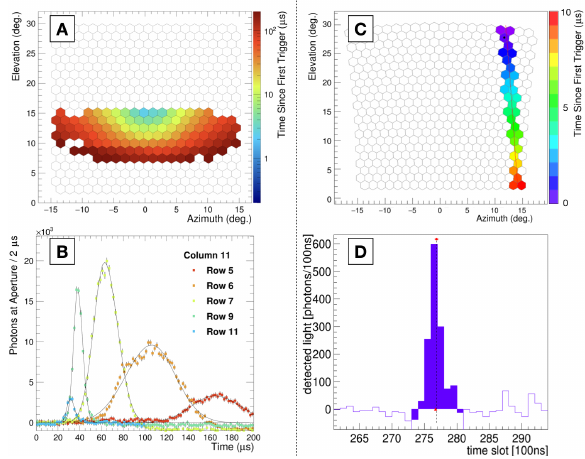
Figure 3. The comparison between the elve signal (panels A and B in the left column) and the cosmic-ray signal (panels C and D in the right column) in the FD. The distinctions to focus on are the amplitude and length of the traces, as well as the signal geometry on the camera. Panel A: a time projection of the elve onto the camera. The time of the peak maximum was chosen for the log color scale. Each hexagon is a FD pixel. Panel B: Se- lected pixel traces of column 11. All traces were binned every two microseconds to limit the clutter on the plot and fitted with a skewed Gaussian distribution. Panel C: a time projection of a cosmic ray onto the camera. The black dot, in the purple pixel, shows the selected trace presented in panel D. Panel D: One se- lected trace of a pixel high in the camera, with the location of the fitted peak